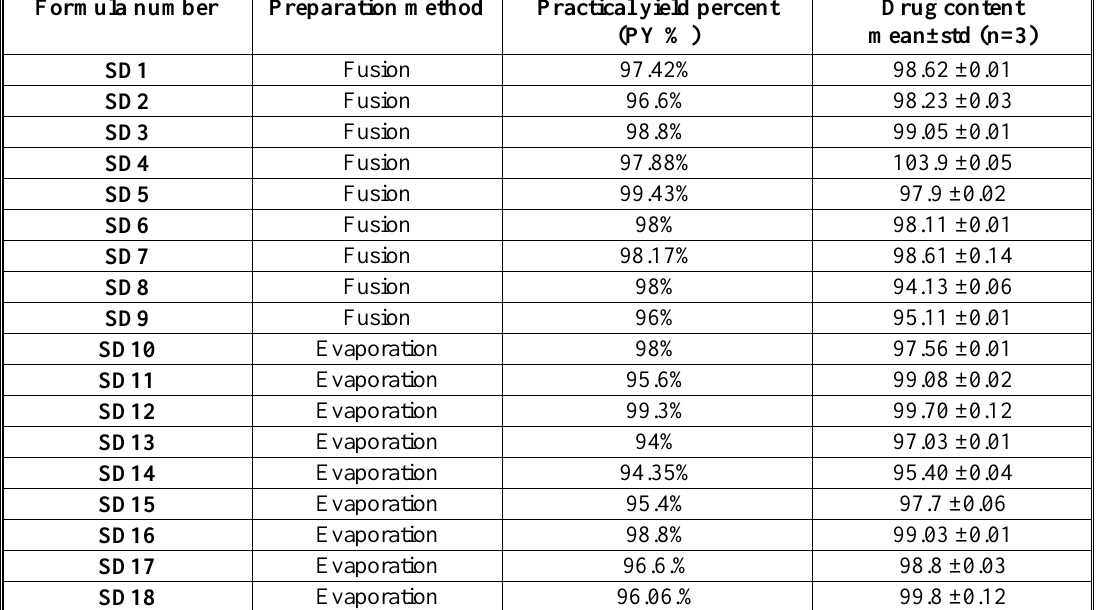
Table 3. The practical yield percent (PY %) and drug content of EXB solid dispersion using different methods Formula